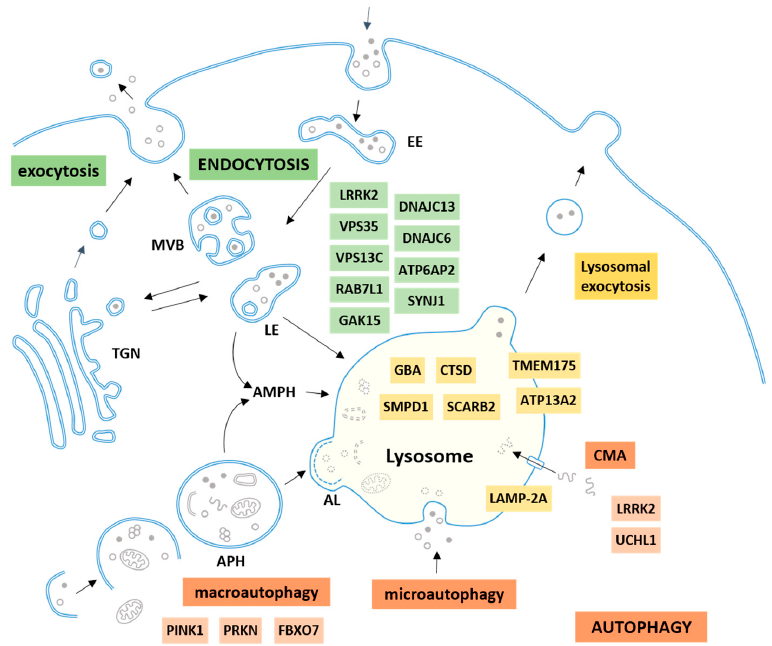
Figure 1. The autophagy–lysosomal–endosomal system and the Parkinson’s disease (PD)-related proteins. Lysosomes are the terminal compartment where the intracellular macromolecules delivered by autophagy (orange) and the extracellular macromolecules delivered by endocytosis (green) are degraded. Three types of autophagy are described in mammalian cells: macroautophagy, microautophagy, and chaperone-mediated autophagy (CMA). Macroautophagy eliminates intracellular